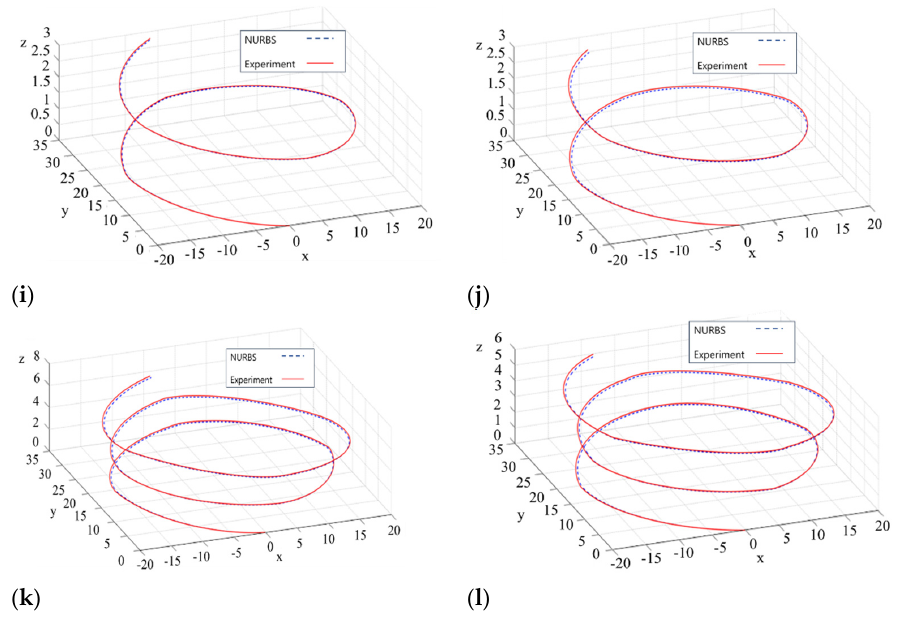
Figure 8. Comparative analysis of torsion springs: ( a ) d = 2.6 mm, D = 32.6 mm, n = 1.5 (20°); ( b ) d = 2.6 mm, D = 32.6 mm, n = 1.5 (40°); ( c ) d = 2.6 mm, D = 32.6 mm, n = 2.5 (20°); ( d ) d = 2.6 mm, D = 32.6 mm, n = 2.5 (40°); ( e ) d = 2.8 mm, D = 32.8 mm, n = 1.5 (20°); ( f ) d = 2.8 mm, D = 32.8 mm, n = 1.5 (40°); ( g ) d = 2.8 mm, D = 32.8 mm, n = 2.5 (20°); ( h ) d = 2.8 mm, D = 32.8 mm, n = 2.5 (40°); ( i ) d=3.0 mm, D = 33.0 mm, n = 1.5 (20°); ( j ) d = 3.0 mm, D = 33.0 mm, n = 1.5 (40°); (k) d=3.0 mm, D = 33.0 mm, n = 2.5 (20°); ( l ) d = 3.0 mm, D = 33.0 mm, n = 2.5 (40°).